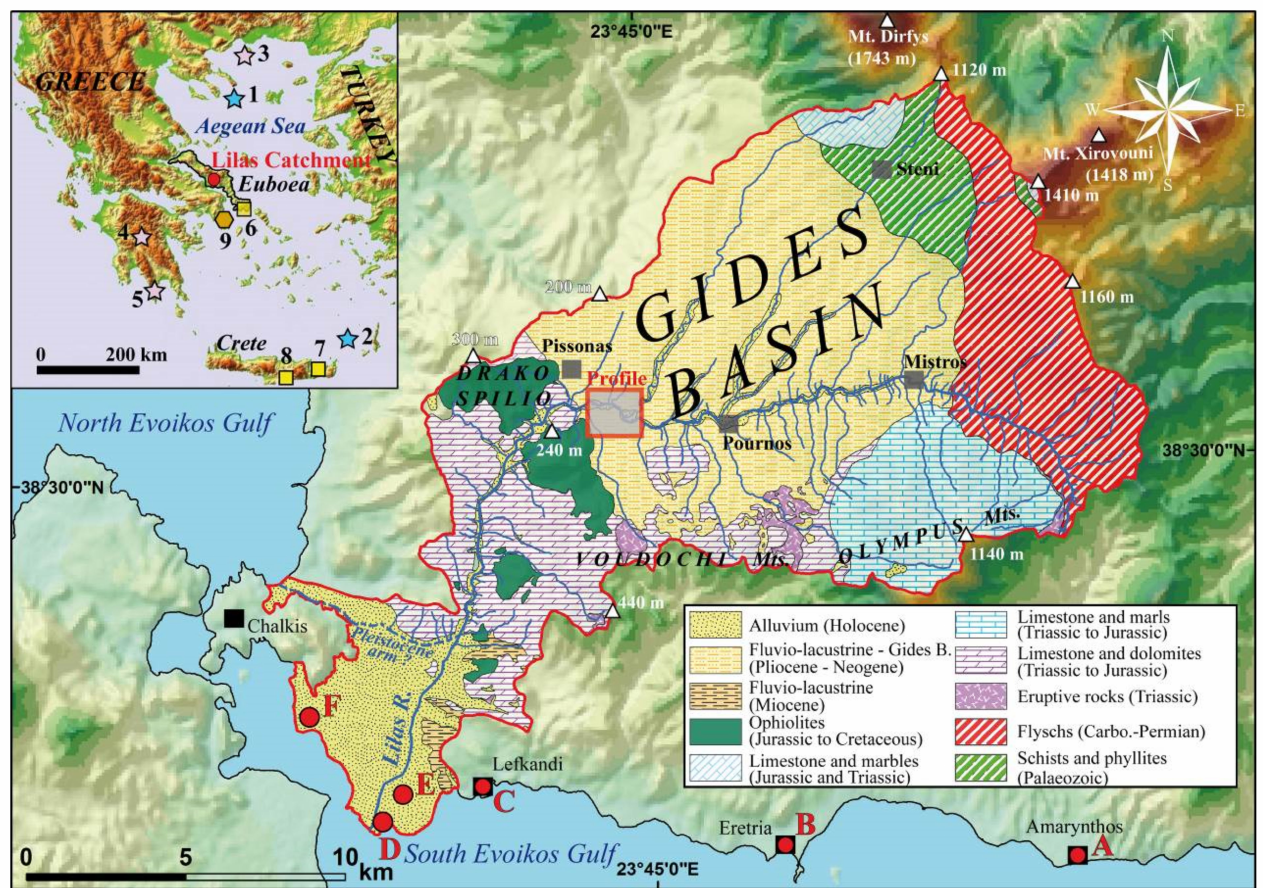
Figure 1. Geological map of the Lilas drainage basin. Geological data derived from 1/50,000 scale IGME geological maps. Black squares: archaeological sites mentioned in the text; grey squares: modern towns in the Lilas drainage basin; red circles: sedimentological cores obtained along the South Evoikos Gulf: A, B, C and D [31]; E and F [32]. Digital Elevation model derived from SRTM data (WGS 84 projection datum). In the inset map: stars indicate the location of palaeoclimate archives (in blue, marine core and light purple, speleothems); yellow squares indicate the location of palaeofluvial studies and orange polygons, the position of full pollen sequence. 1: M2 core [33,34]; 2: LC21 core